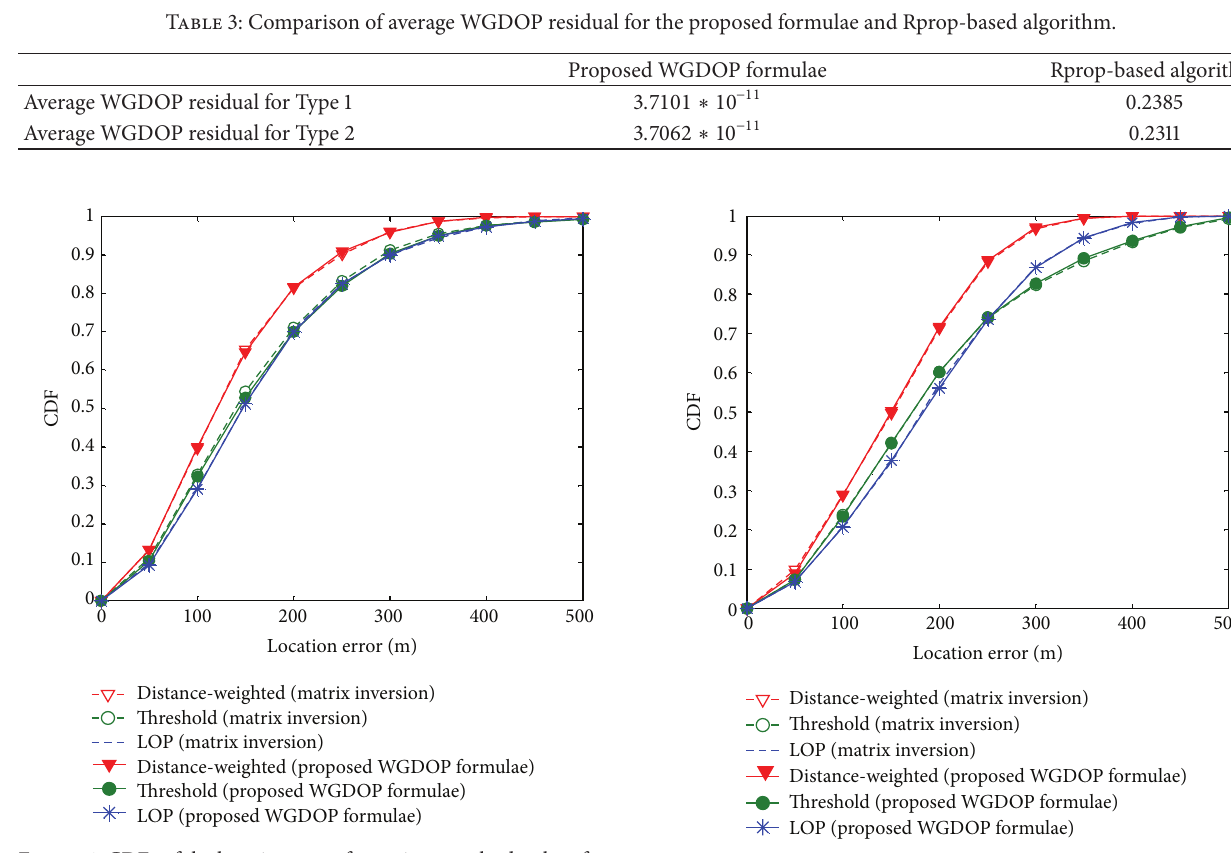
Figure 2: Comparison of CDFs of location error for various methods when four measurements have two types of error variances (Type